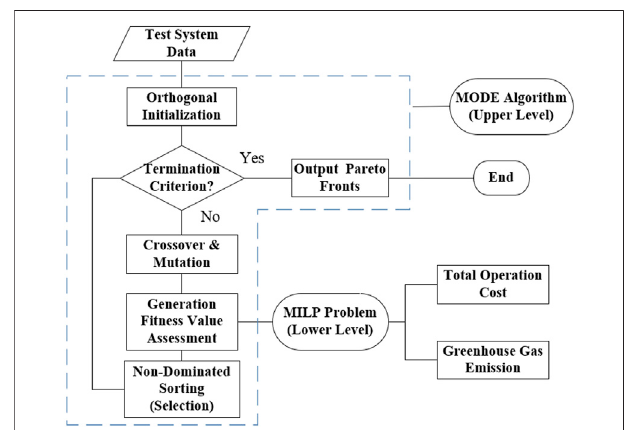
FIGURE 4 | Flow chart of the proposed bi-level